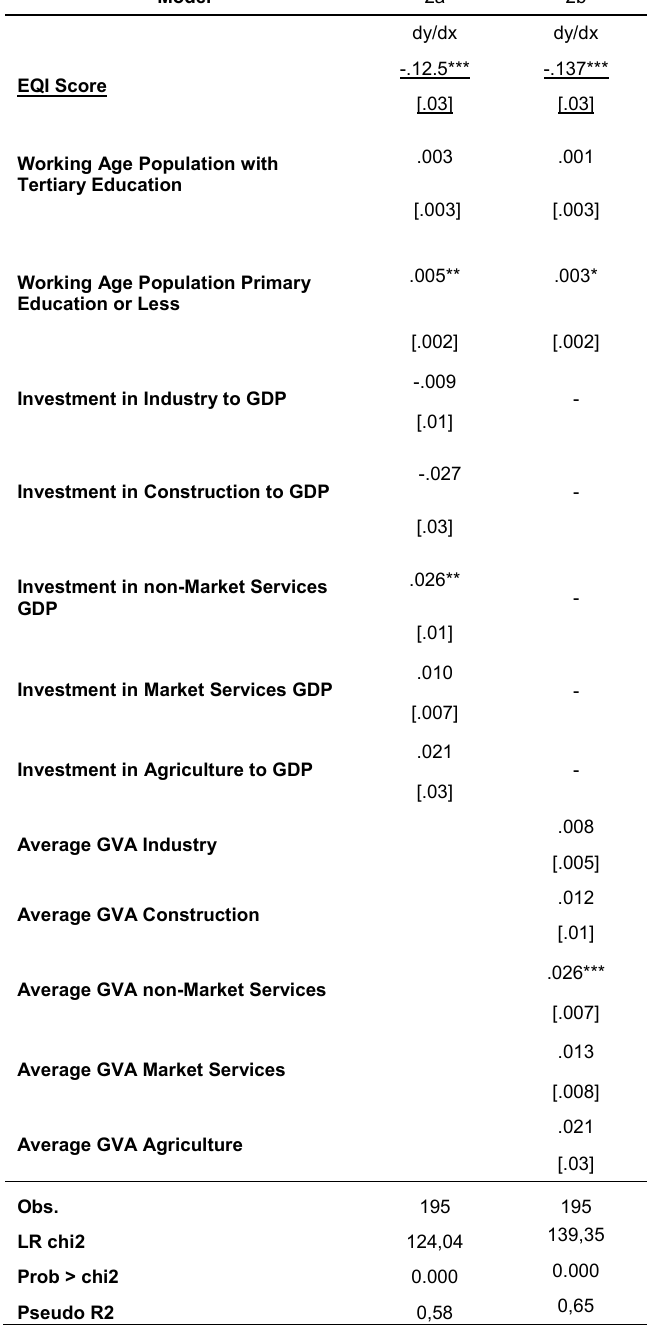
Table 3. Marginal effects on probability Y=1|X. Group